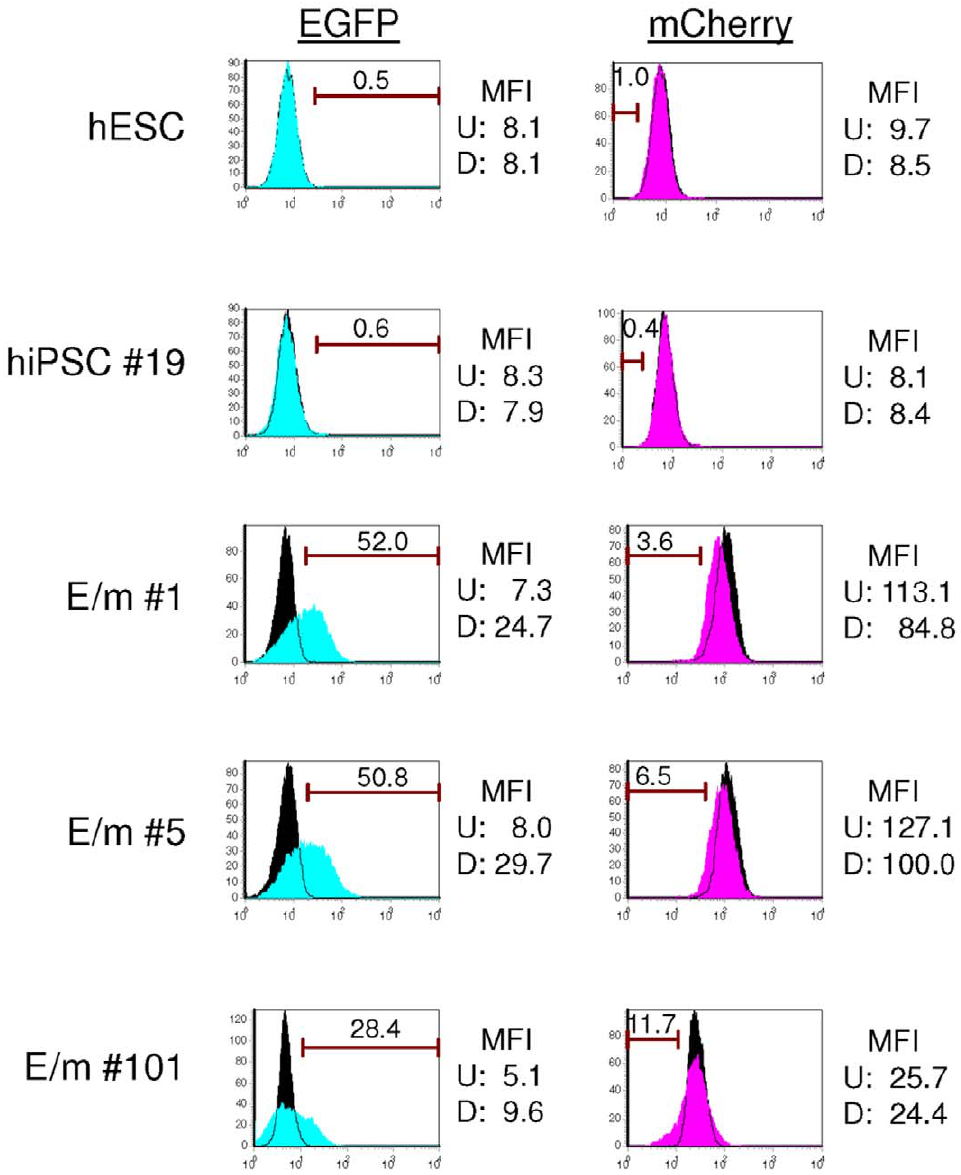
Figure 6. hiPSCs transduced with the reporter vector containing miRNA targets show differentiation-specific reporter expression in EBs. hESC (H1) and 4 different hiPSC clones (E/m # 1, E/m # 5, E/m # 101, and hiPSC # 19) were differentiated into EBs and maintained 25 days in IMDM containing 10% FBS. EBs were then dissociated with 0.25% trypsin/EDTA and the reporter expression was analyzed by flow cytometry. Histograms filled with black are undifferentiated controls. Histograms filled with blue (EGFP) and pink (mCherry) are differentiated cells, respectively. The numbers indicated in histogram show percentage of positive cells (EGFP) and negative cells (mCherry). MFI: mean fluorescence intensity. U: MFI of undifferentiated cells. D: MFI of differentiated cells.